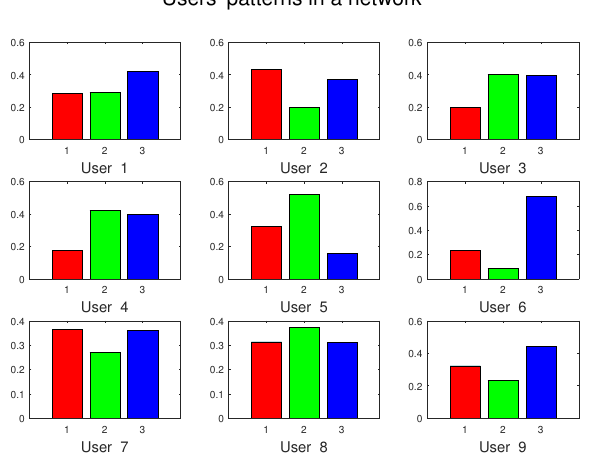
Figure 9. A demonstration of network behaviors. Only nine users with their patterns over three categories of data (distinguished by colors) are